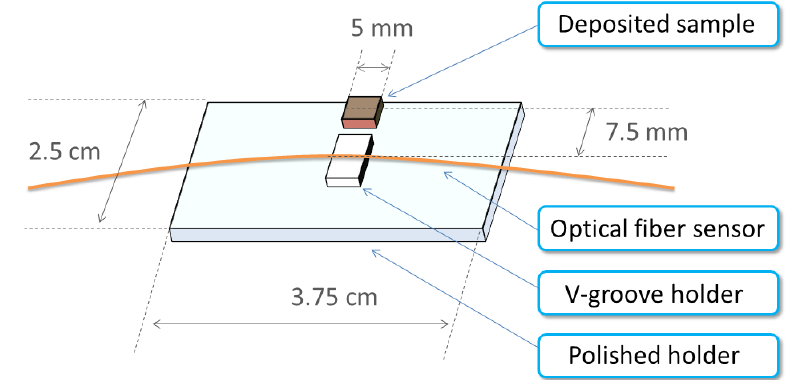
Figure 2. Schematic diagram of the setup for the SPR optical fiber sensor and deposited sample.